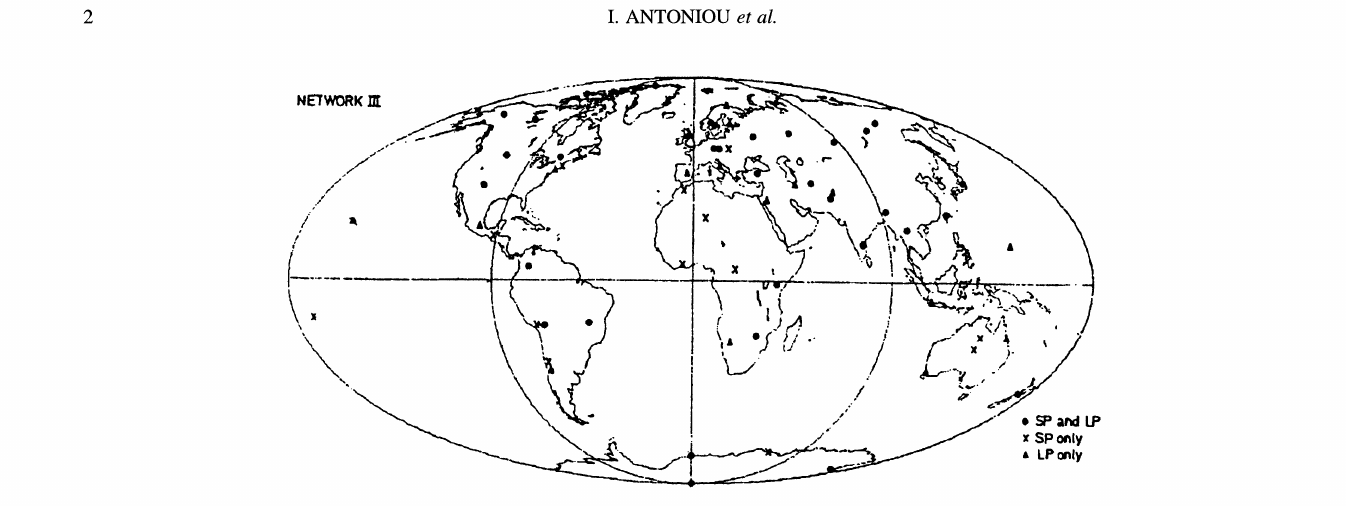
FIGURE A possible global network of existing and planned seismic observatories proposed by the CD ad hoc group of seismic experts. 4. To distribute, in accordance with defined procedures and without interpretation of identification